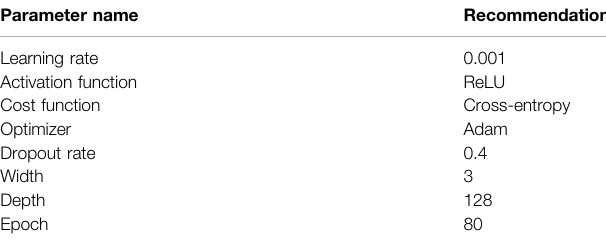
TABLE 1 | Parameters of the CNN model